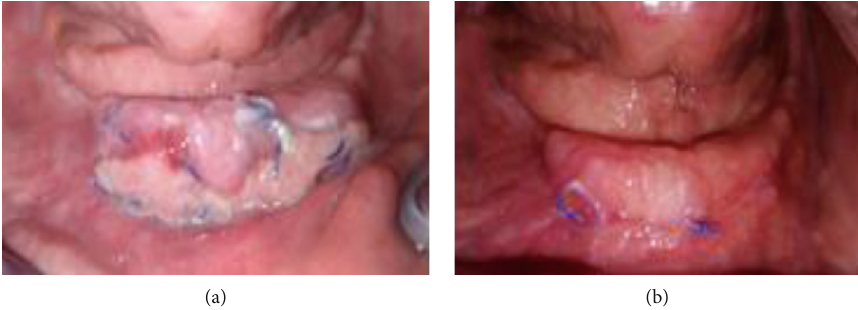
Figure 7: Healing process of the treated area: (a) 7 days and (b) 14 days.